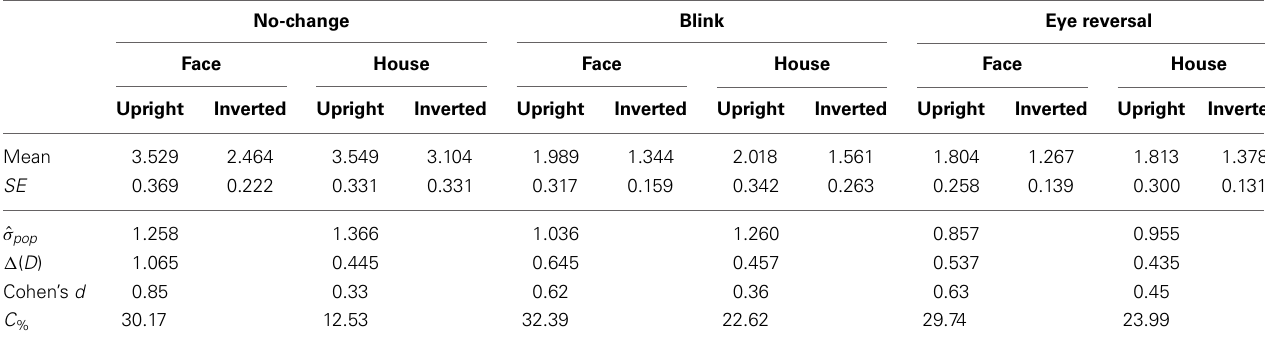
Table 3 | Mean durations of dominance epochs (seconds) for rivalry of upright versus inverted objects ( N = 17).